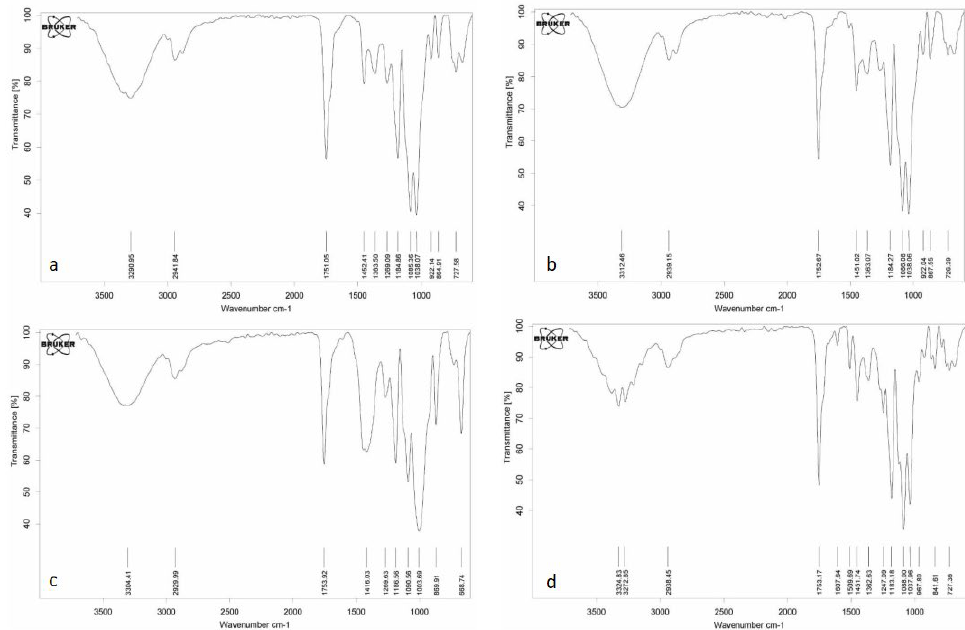
Figure 2. FTIR spectra of PLA films incorporated with different concentrations of anise essential oil (AE): neat PLA ( a ); PLA/0.5AE ( b ); PLA/1AE ( c ); PLA/1.5AE ( d ).